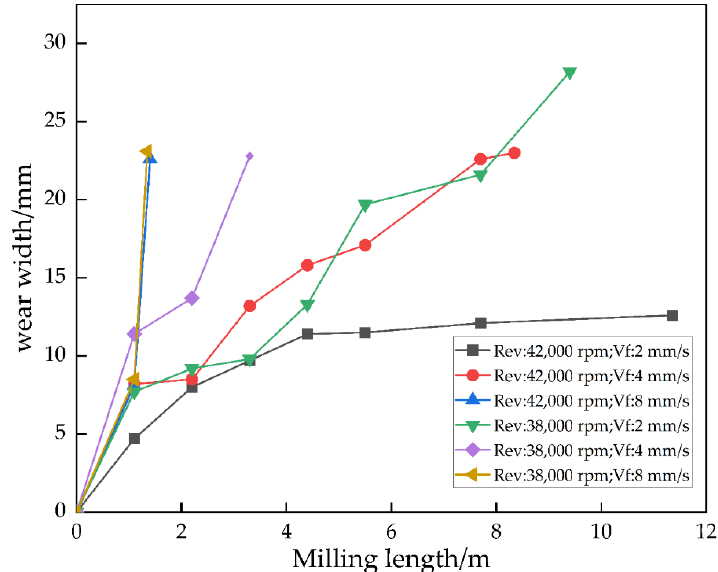
Figure 15. Flank wear value of the cutting edge of coated milling cutters with different milling